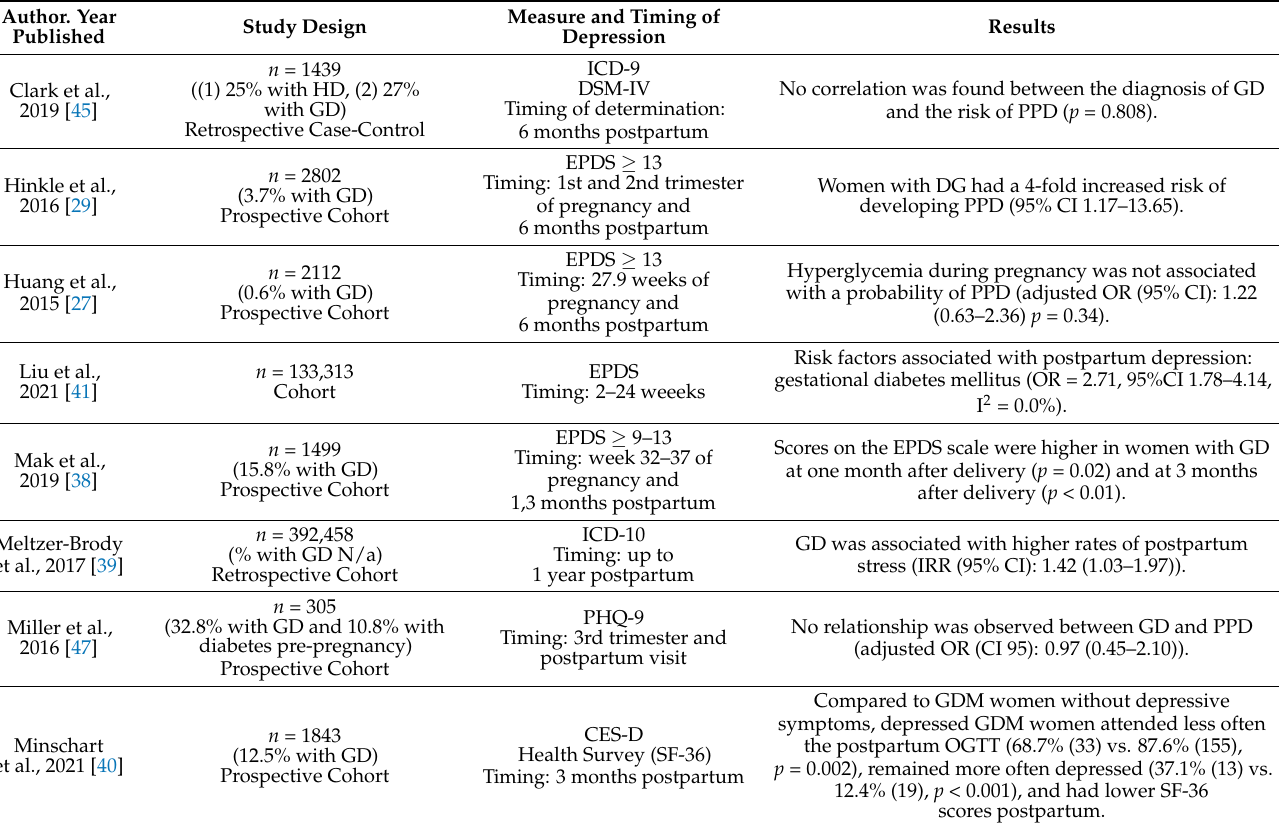
Table 3. Outcomes of studies evaluating postpartum depression in women with gestational